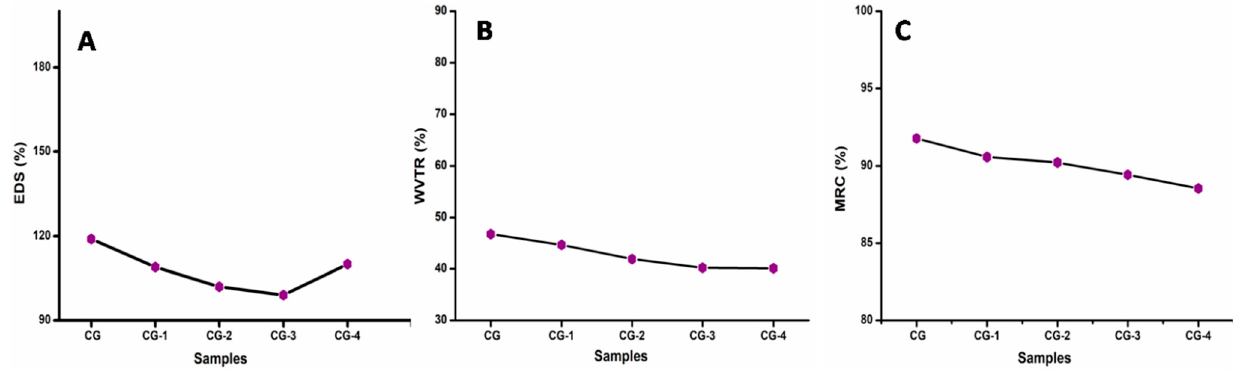
Figure 9. ( A ) Swelling Degree of films. ( B ) WVTR of films. ( C ) MRC of